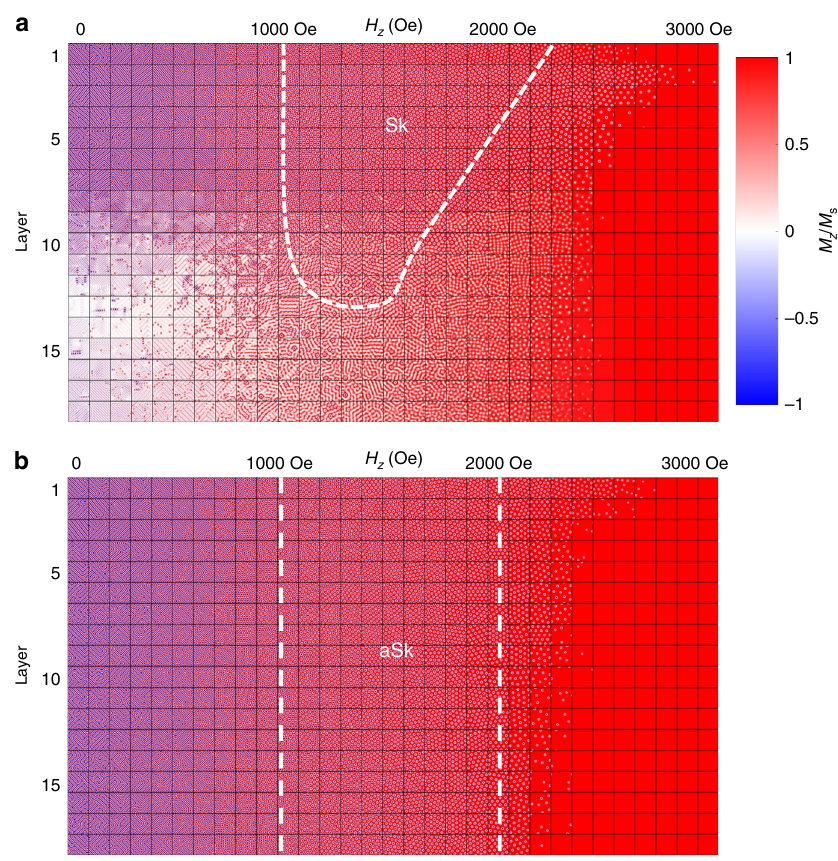
Fig. 5 Micromagnetic simulations of the phase diagrams of B20 and D 2 d systems. A table of micromagnetic simulations of the magnetic texture for various magnetic fi elds ( B ) and thicknesses with increasing B along the abscissa and increasing thickness along the ordinate. For each calculated image in the table, the averaged M z along the thickness direction is plotted, where the color indicates the amplitude of M z normalized by the saturation magnetization M s . Red/blue corresponds to M z / M s = + 1/ − 1. a In a B20-type material, the fi eld region of the skyrmion phase decreases as the thickness increases and fi nally disappears. b In a D 2 d -type material, the fi eld region of the anti-skyrmion phase is unchanged as the thickness is increased. The simulations included in the Table are shown in higher magni fi cation in the Supplementary